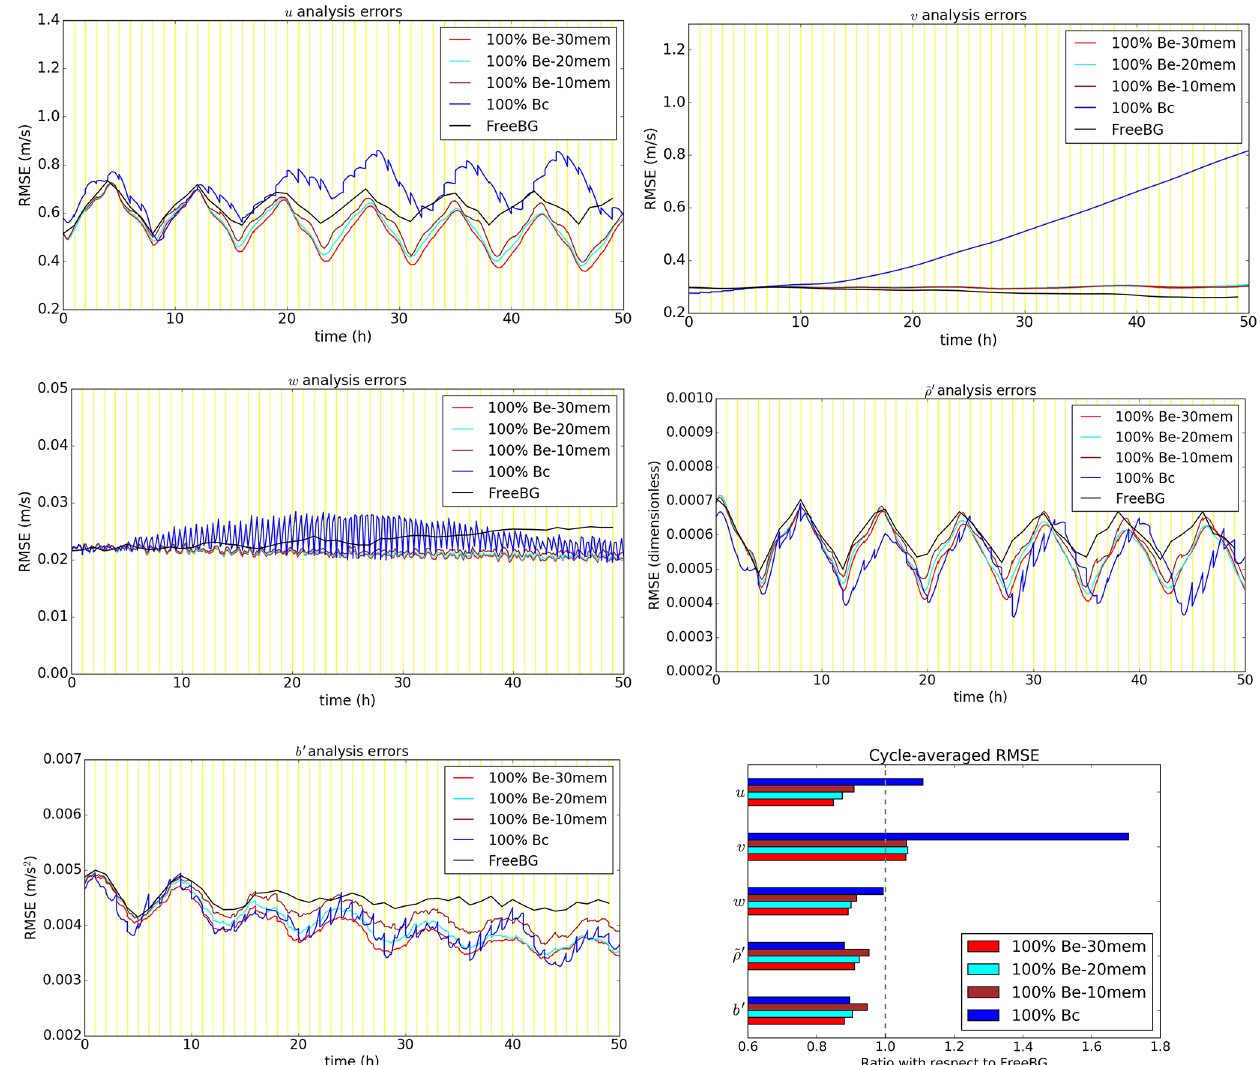
Figure 8. As in Fig. 5, but for EBV(d), EBV(d20), and EBV(d10) experiments (100% B e with 30, 20, and 10 ensemble members, respec-